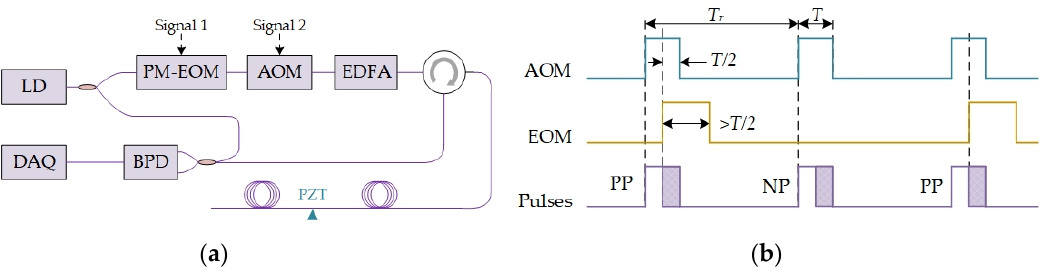
Figure 8. ( a ) System setup of single pulse scheme; ( b ) Time sequence of probe pulses. Reproduced from our previous paper [64].